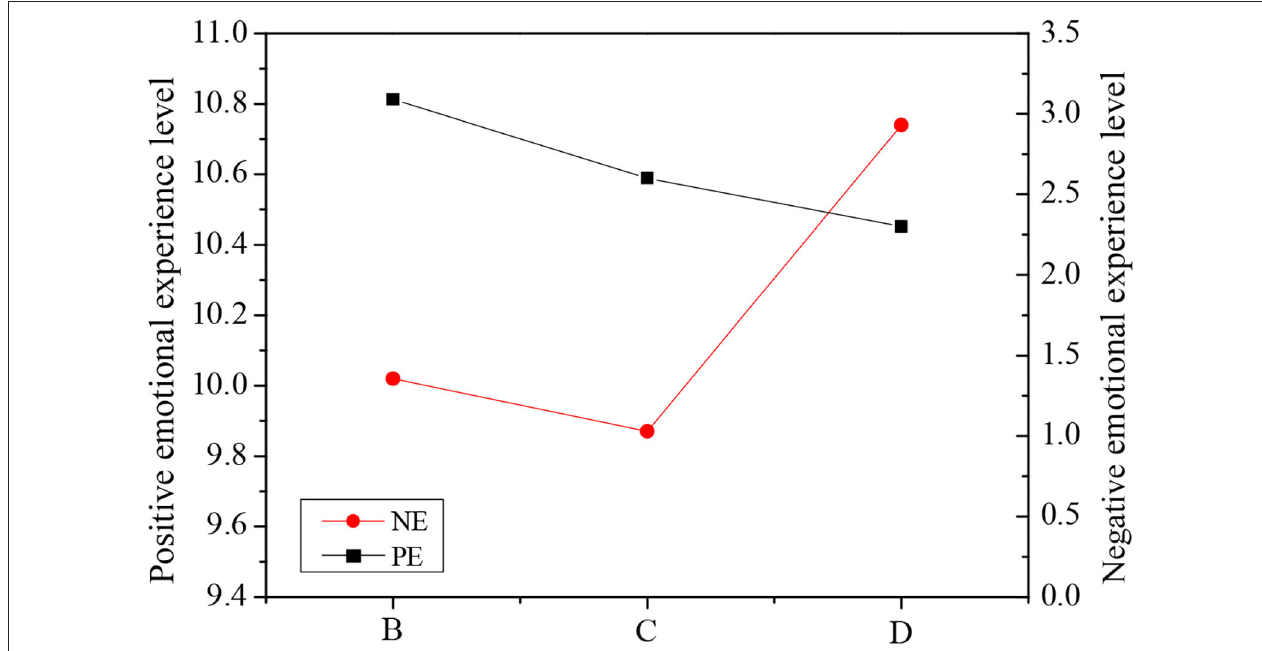
FIGURE 6 | Comparison of PE and NE among the elderly in different time study